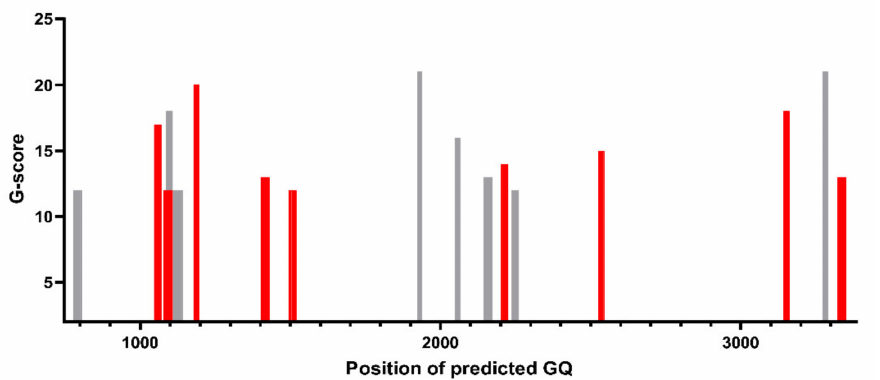
Figure 6. GQRS mapper prediction of GQs in the wt poliovirus 1 P1 region (NC_002058.3; grey) vs. the recoded sequence (P1-Max = EU095952; red). The P1 region comprises nucleotides from 746–3385 of the poliovirus